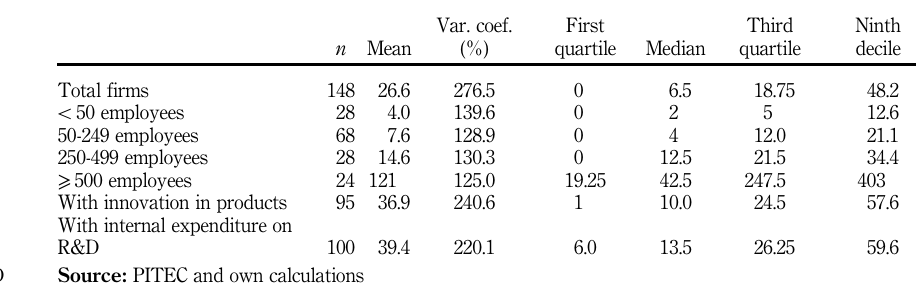
Table I. Number of firms by size and type of capital